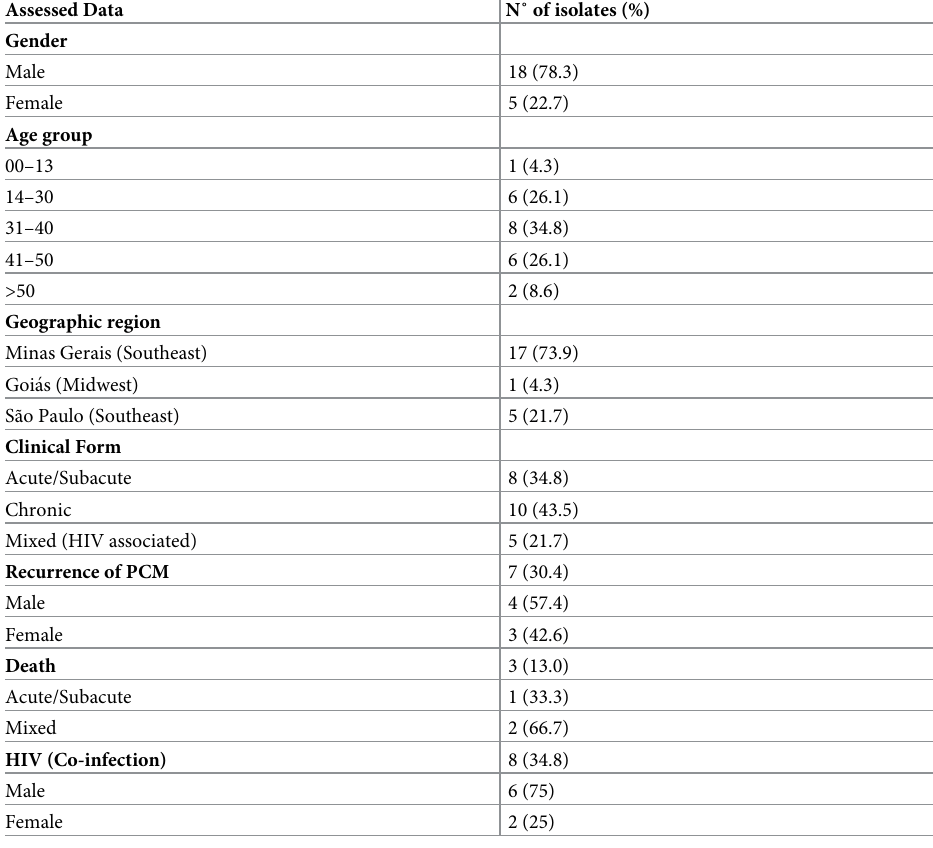
Table 1. Main clinical and epidemiological data of 23 patients with PCM of whom isolates of Paracoccidiodes spp. were obtained. Assessed